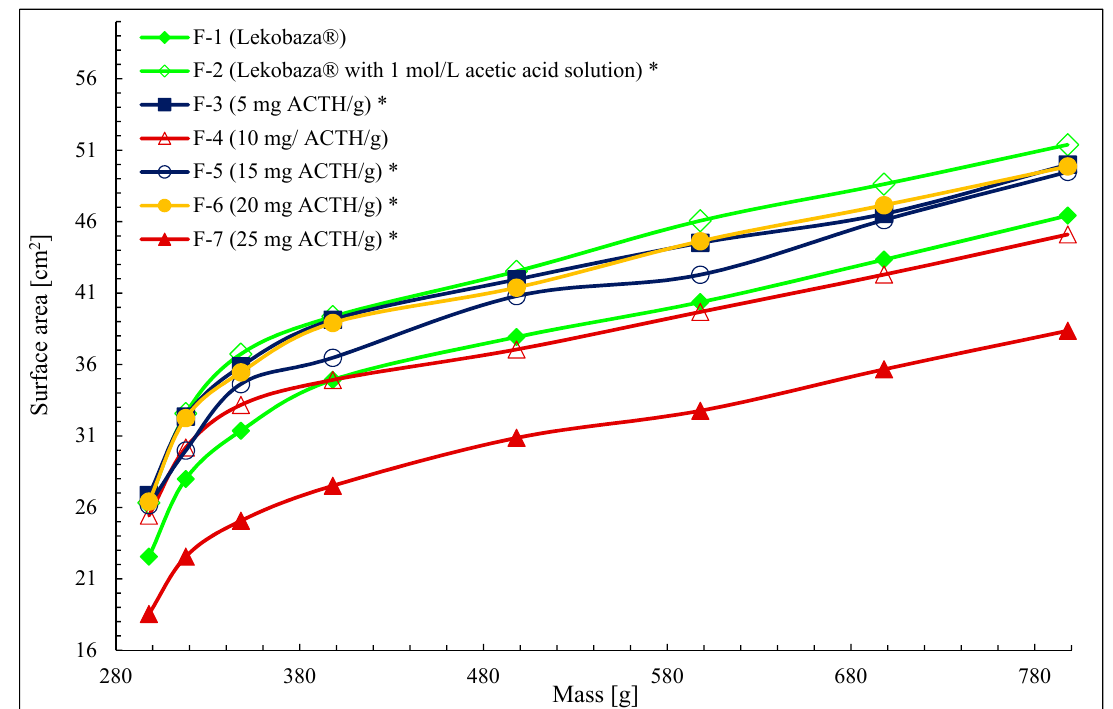
Figure 1. The dependence of the sample surface area vs. applied mass, *—the statistically significant difference relates to F-1 ( p < 0.05).